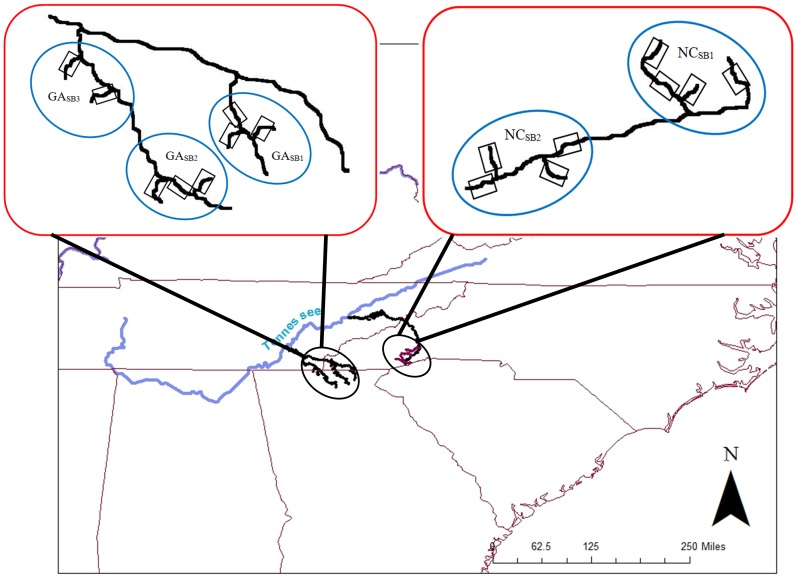
Drainage (Hierarchical) scale sample design for eastern hellbenders showing basin (red rounded box), sub-basins (blue circles), and stream reaches within sub-basins (boxes).All basins are within the Tennessee River drainage. Basins consist of French Broad River, North Carolina (sub-basins NCSB1, NCSB2) and Hiawassee River, Georgia (GASB1 GASB2, & GASB3).